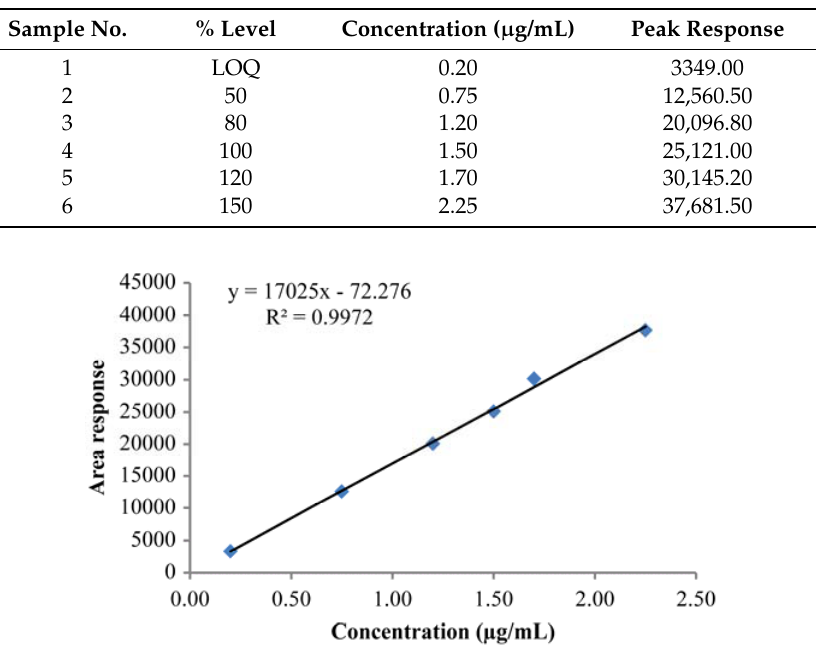
Table 5. Accuracy of S ‐ enantiomer detection in the rasagiline mesylate mixture at various concentration levels.